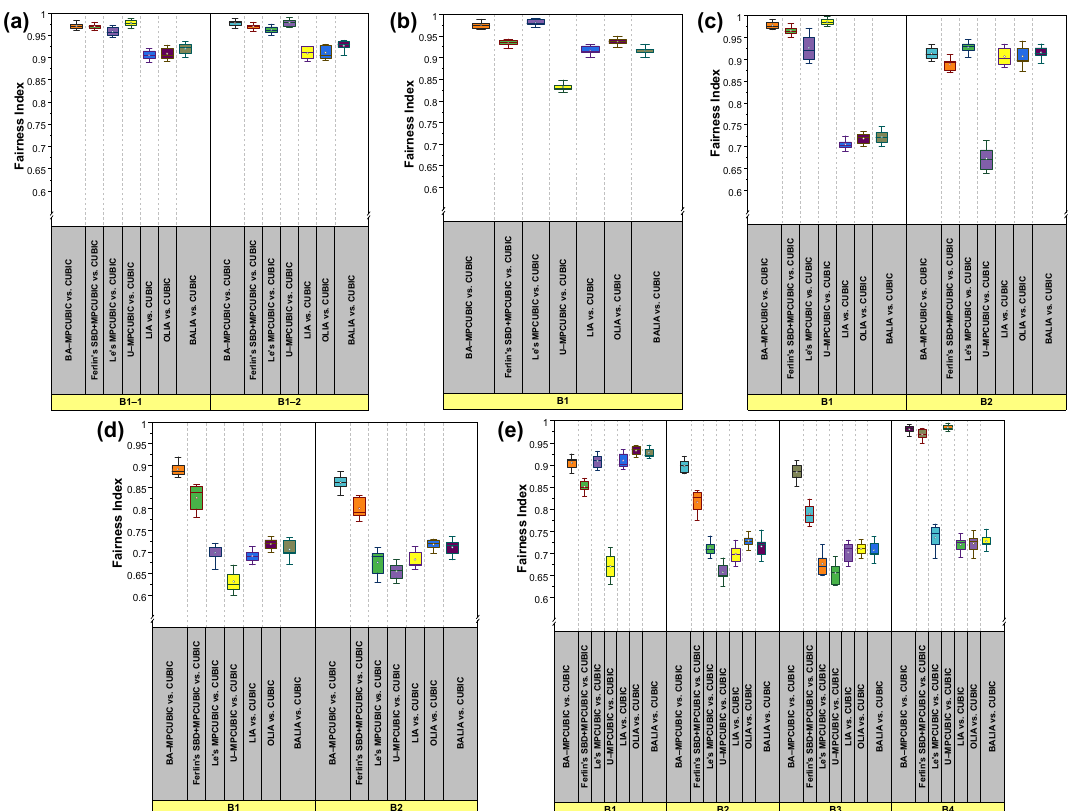
Figure 8. Performance comparison in terms of fairness index for the considered MPTCP CCAs. ( a – e ) fairness index for Scenarios #1–5.